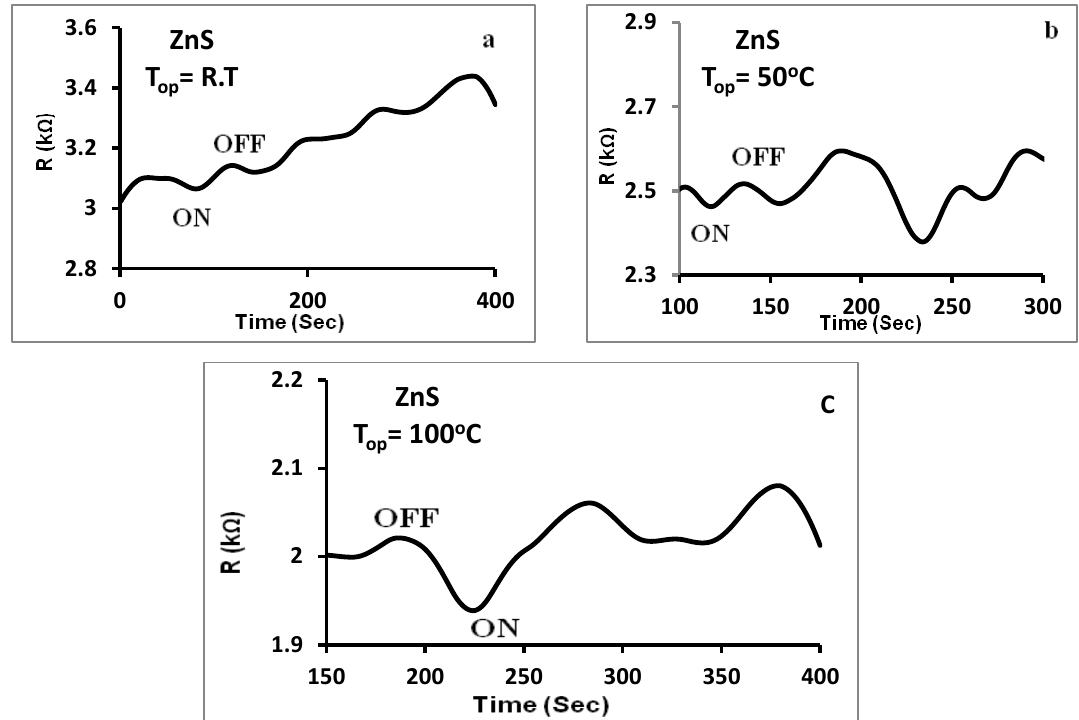
Fig.4: The variation of resistance with time for pure ZnS against NO temperatures: a) R.T; b) 50 o C and c) 100 o